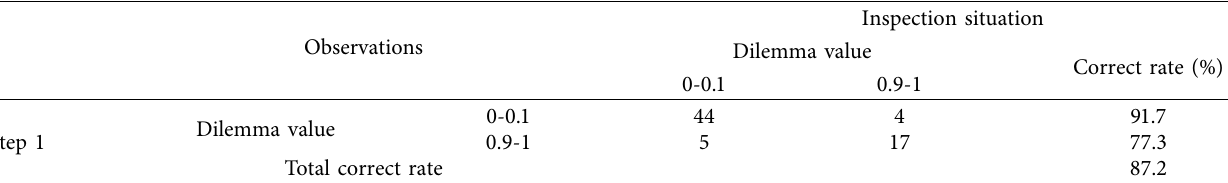
Table 2: Observations and tests of step